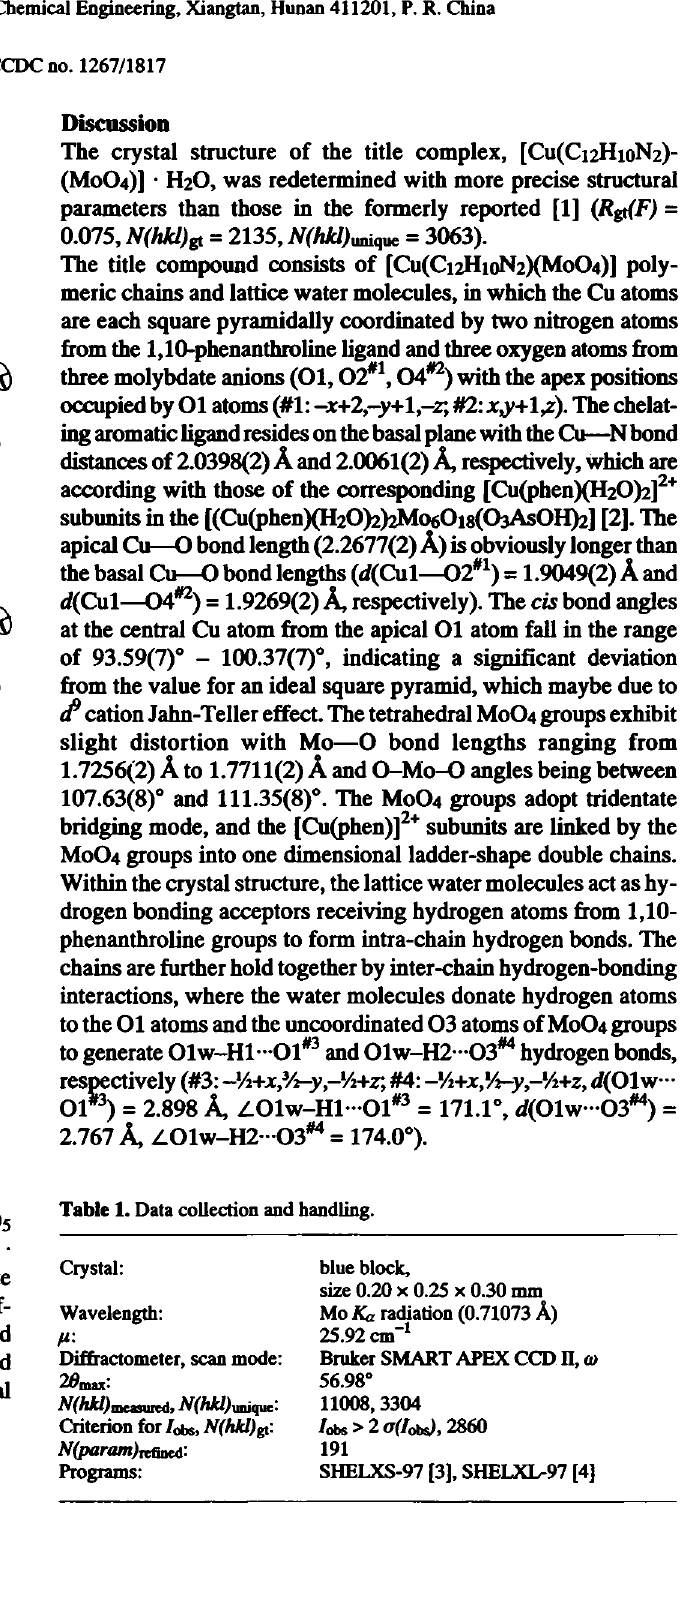
Table 1. Data collection and